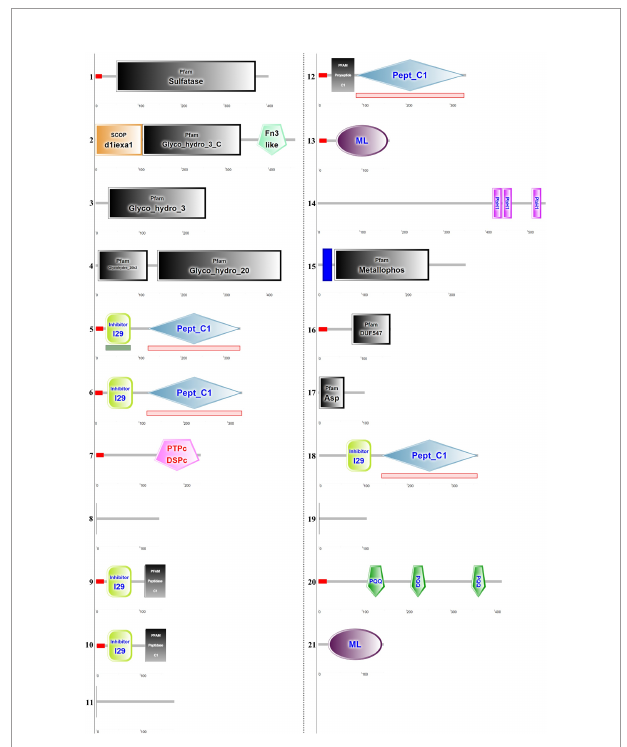
FIGURE 3 | Schematic conserved domain representation of the proteins extracted from the spicules. The analysis was performed using the deduced amino acids sequences obtained after in silico translation of contigs correspondent to MS-identi fi ed peptides. The conserved domain has been identi fi ed using the Simple Modular Architecture Research Tool (SMART) program (http://smart.embl-heidelberg.de/). The detailed legend is reported in Supplementary File 2 . The domains list is reported in Table 1 . The contig sequences identi fi ed are reported in Supplementary File 3